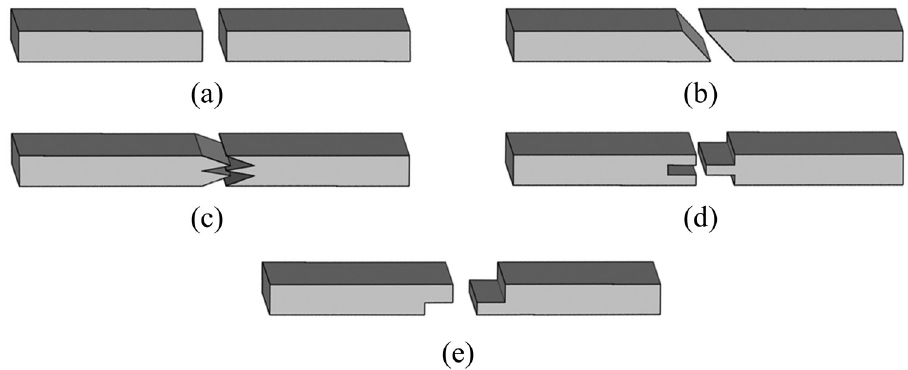
Figure 5: Laminate board connection variations: ( a ) butt joint, ( b ) scarf joint, ( c ) fi nger joint, ( d ) tongue and groove joint, and ( e ) desk joint.